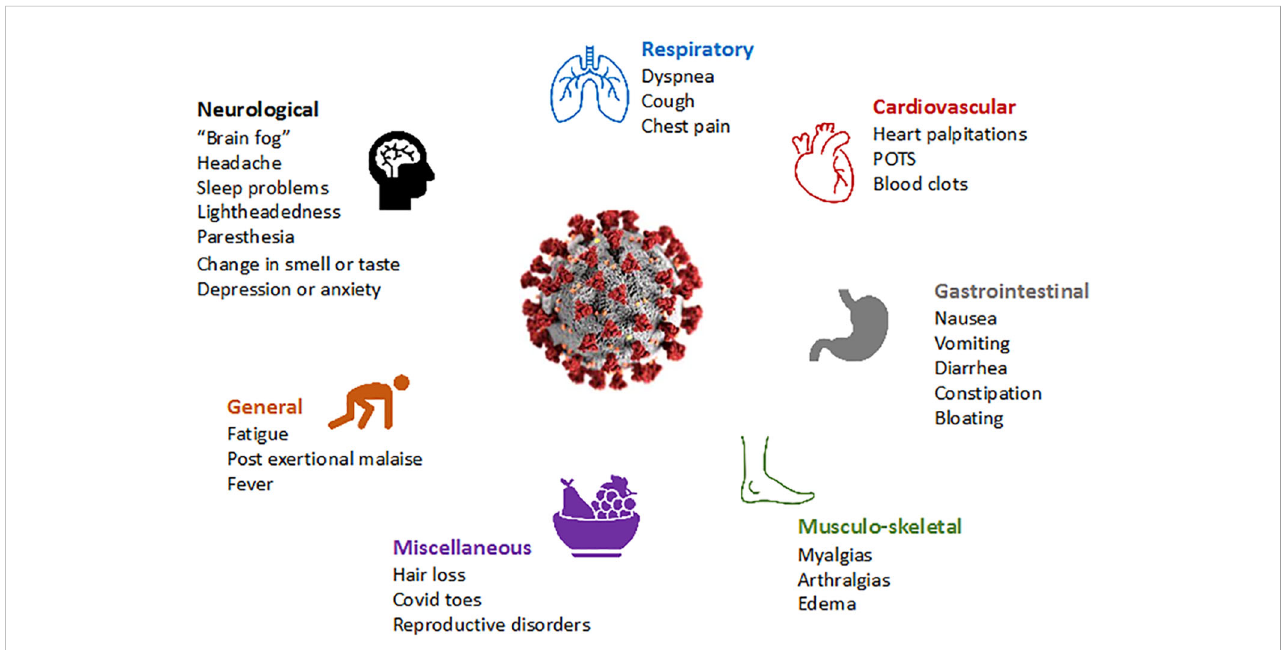
FIGURE 1 Most common symptoms reported in long COVID